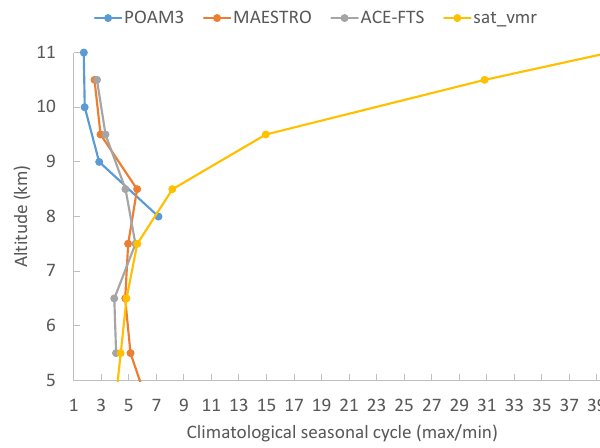
Figure 4. MAESTRO mean climatology (2004–2012) of the ver- tical distribution of the water vapour volume mixing ratio in the Antarctic (60–90 ◦ S) UTLS for months with sufficient sampling of the region. A logarithmic scale is used for the x axis.